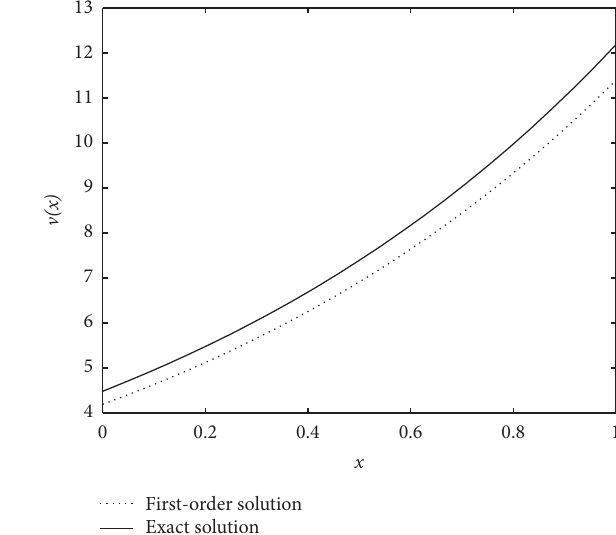
Figure 2: Convergence of second-order solution of 𝑢(𝑥,𝑦, 𝑡) at 𝑡 = 𝑦 = 1 .